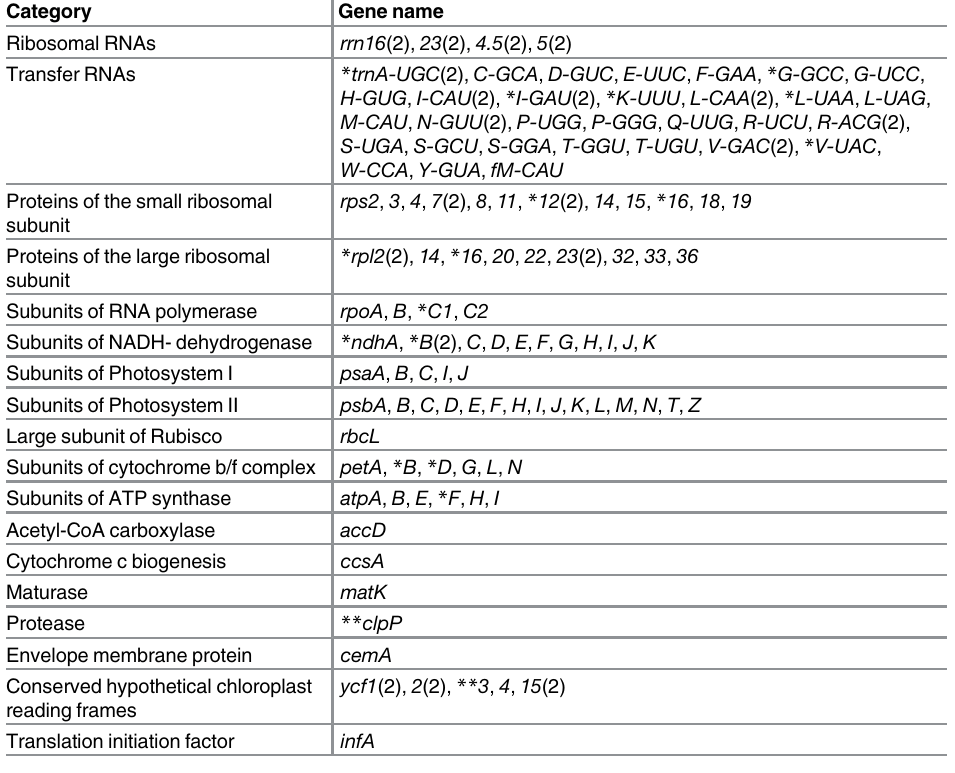
Table 1. Genes located on Diospyros chloroplast